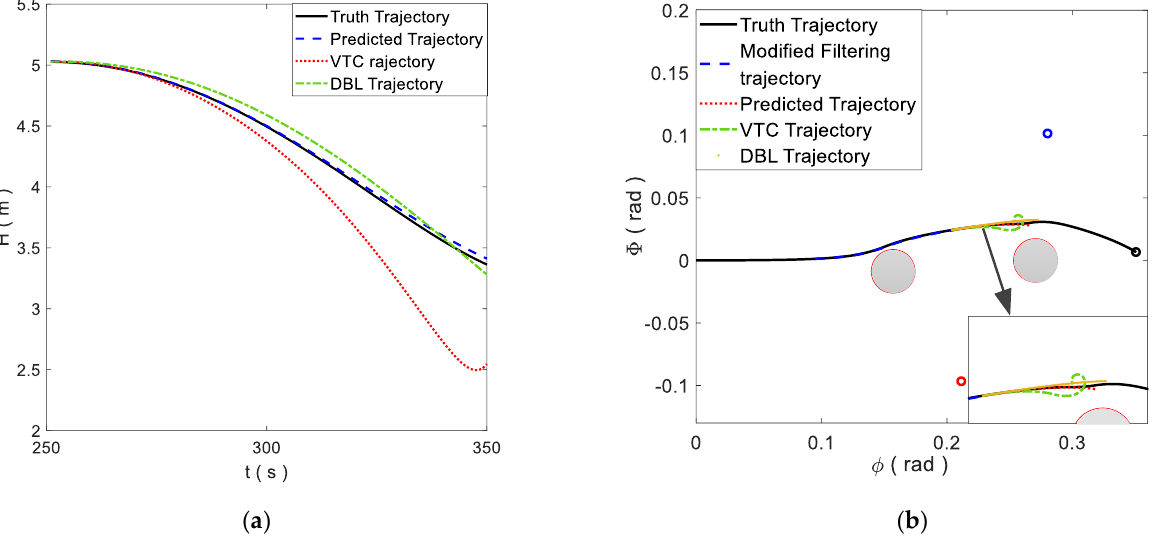
Figure 20. Prediction effect comparison among different methods: (a) represents the short-term longitudinal prediction trajectory; and (b) represents the short-term lateral prediction trajectory.